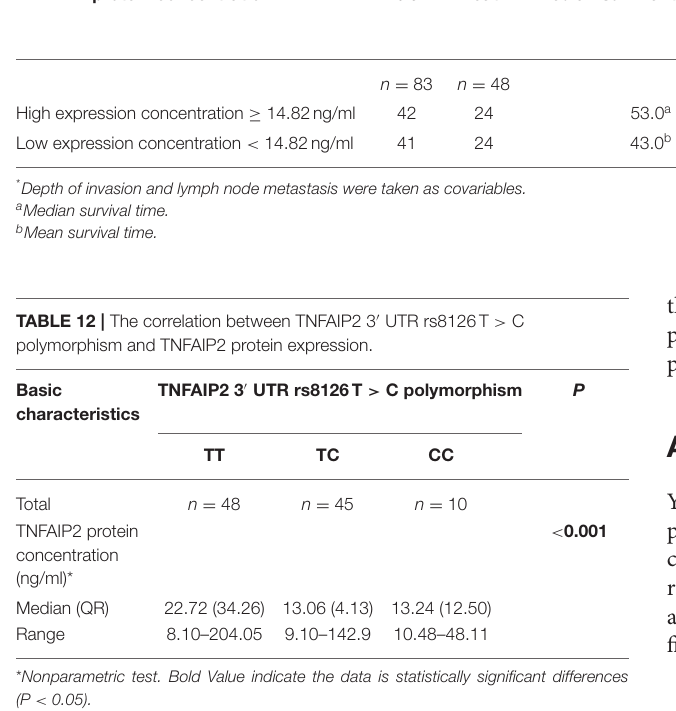
TABLE 11 | The correlation between serum TNFAIP2 protein expression and gastric cancer (GC) prognosis. TNFAIP2 protein concentration